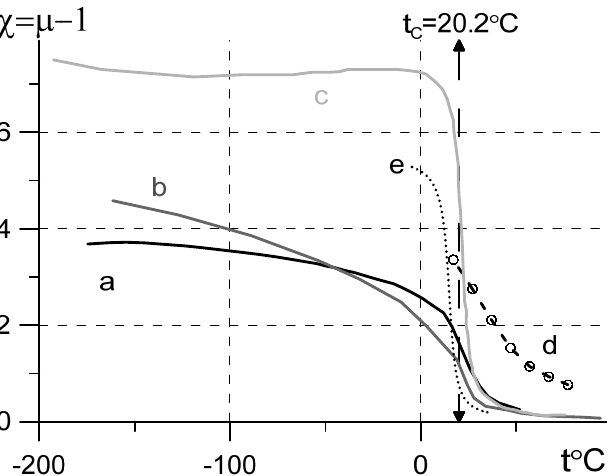
Figure 1. Temperature dependence of Gd susceptibility retrieved from the published magnetization data: curve a is retrieved for bias H = 0.4 T as mean value for two orientations of the monocrystalline sample [6]; curve b is retrieved for H = 0.5 T [7]; curve c is retrieved for H = 0.02 T [8]; curve d is retrieved for H = 1.8 T [11]. The dotted curve e shows the susceptibility of the Gd particle retrieved from susceptibility measurements of the composite under study (see Section 3).